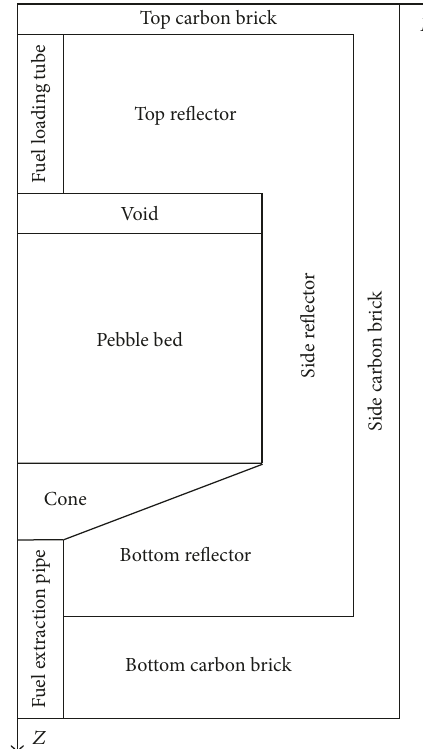
Figure 1: Geometric structure of HTR-PM